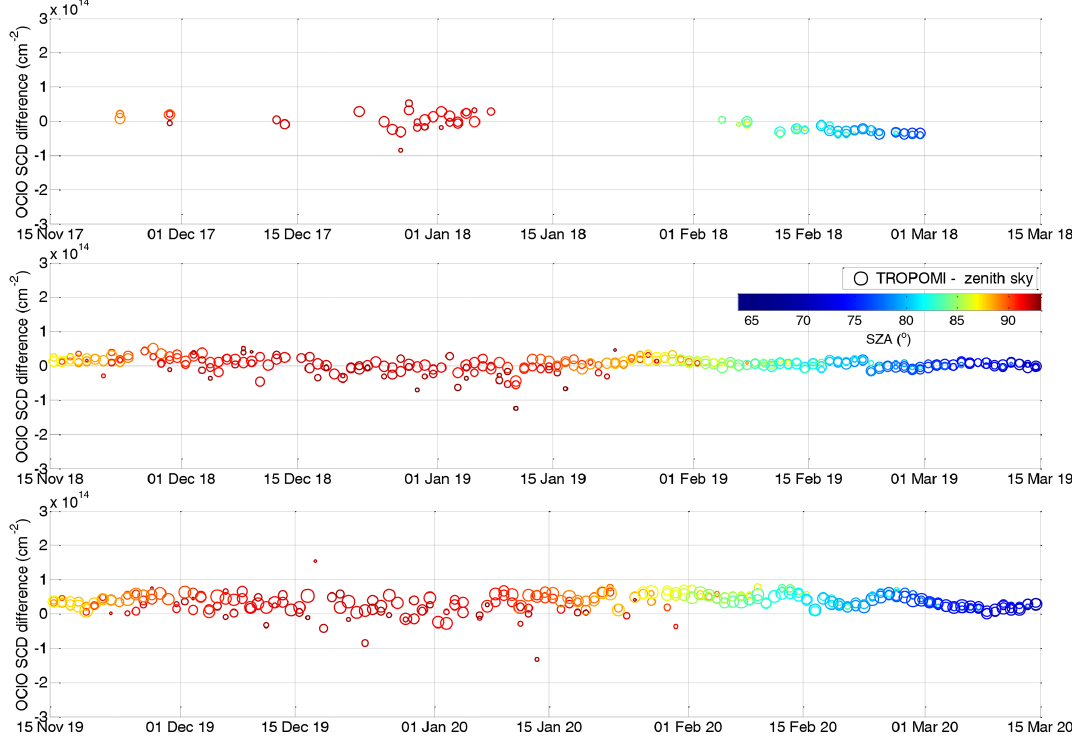
Figure C2. Same as Fig. 5 but considering ground-based OClO SCDs at Kiruna retrieved with Ring spectra at a single temperature and without the OClO × λ term in the DOAS fit for the calculation of the difference.